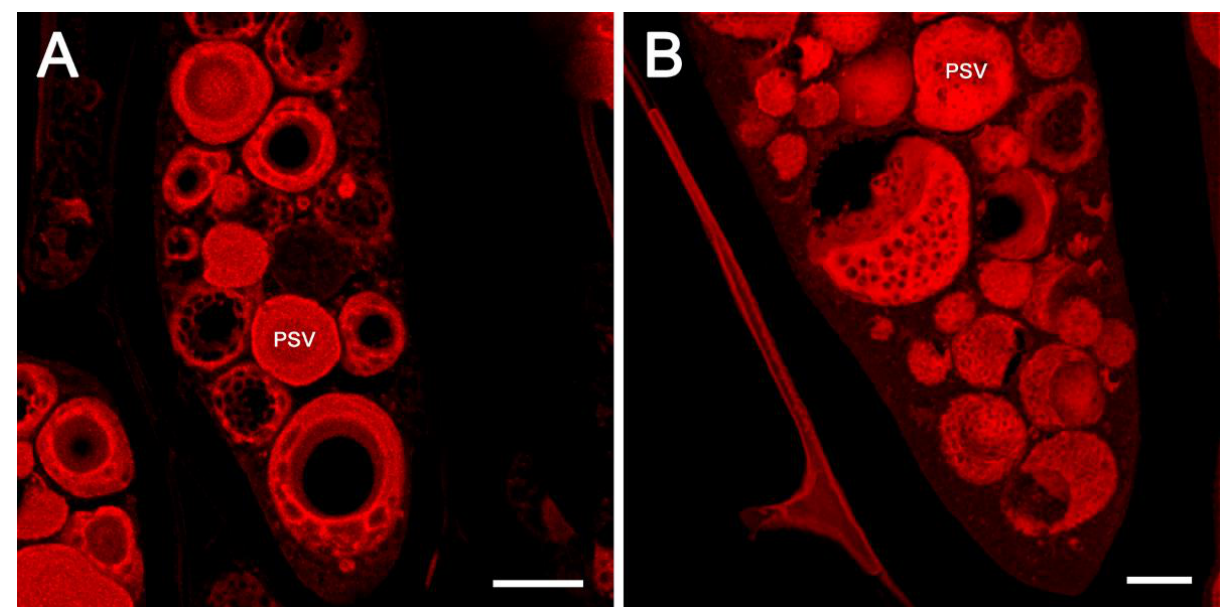
Figure 3. High-magnification confocal images of protein storage vacuoles stained with eosin. A cross-section of soybean cotyledons revealing apparent subdomains in the protein storage vacuoles with a scale bar of 10 µm ( A ). Uniformly spaced cavities on the surface of the PSV with a scale bar of 5 µm ( B ). PSV = protein storage vacuole.